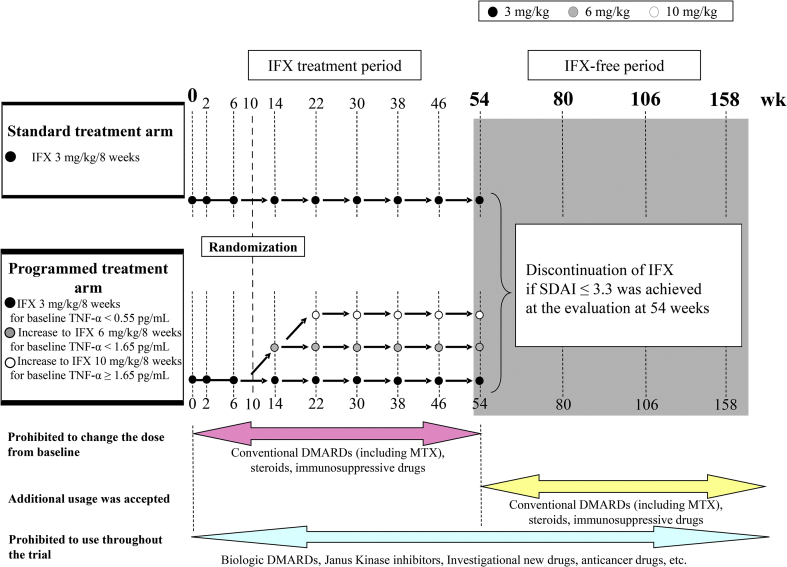
Study Design of the RRRR study.